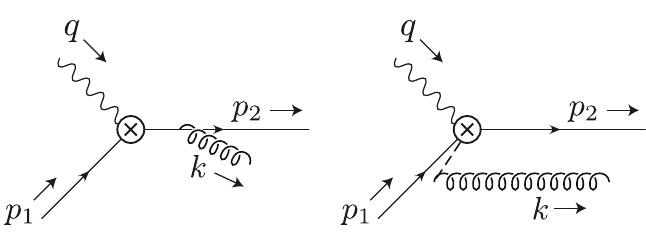
Figure 2 . One-gluon matrix element of O 2 . The dashed line represents a Wilson line W n .